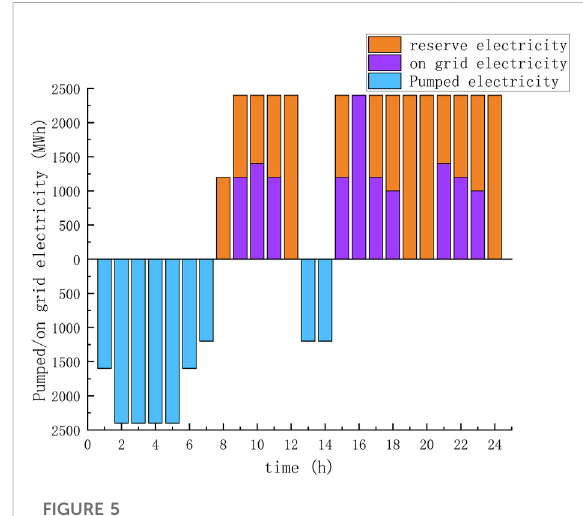
FIGURE 5 Optimal operation of PSPP that both participate in electric energy and ancillary services spot market in scenario 2.